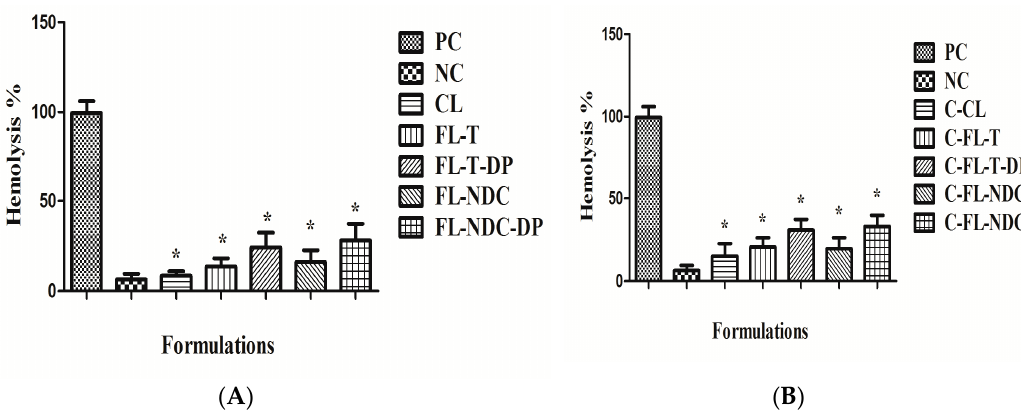
Figure 4. Hemolysis percentage of negative control (NC), positive control (PC), and liposomes ( A ) and chitosomes ( B ). The data are expressed as means ± SD, n = 3. * Significantly decreased from positive control at a p value ≤